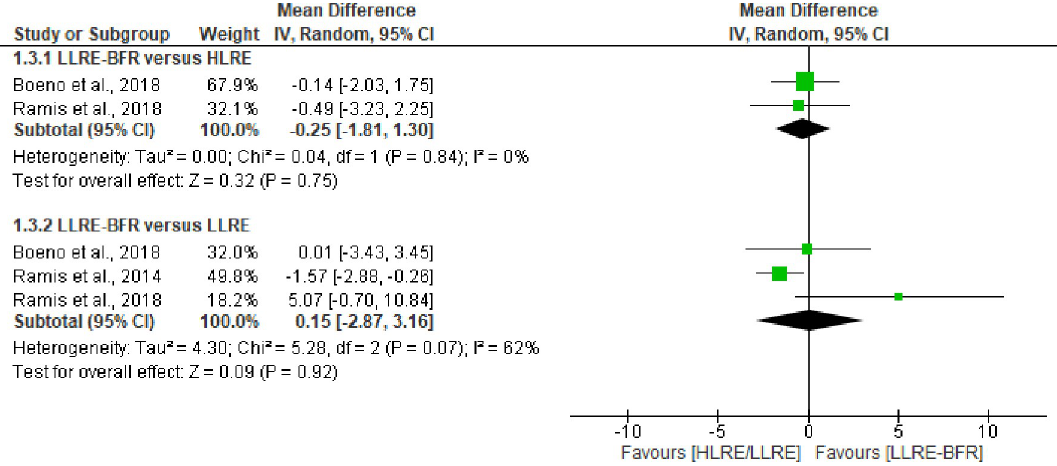
Fig 6. Forest plot about effects of LLRE-BFR versus HLRE and LLRE on catalase activity post-exercise. LLRE-BFR: Low load resistance exercise with blood flow restriction; HLRE: High-load resistance exercise, LLRE: Low load resistance exercise; MD: Mean difference; SD: Standard deviation; IV: Inverse variance; CI: Confidence